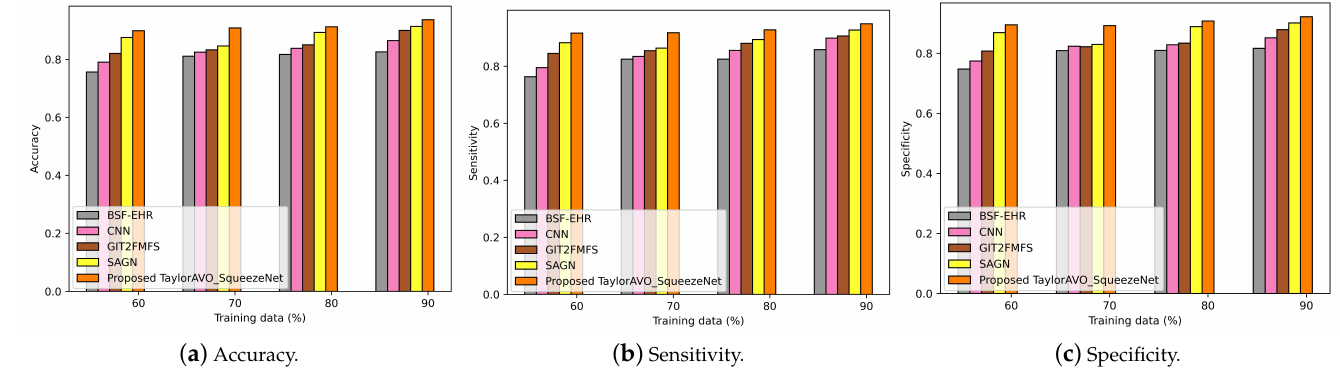
Figure 3. Evaluation of accuracy, sensitivity, and specificity using TaylorAVO-SqueezeNet with other traditional models according to varying training data.